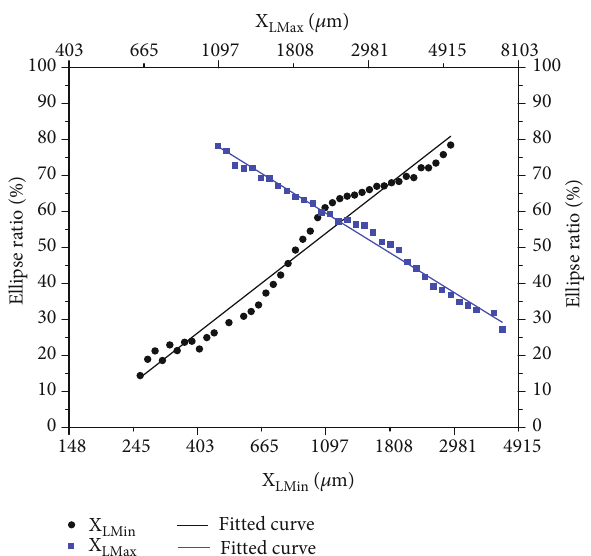
Figure 13: Relationship between the Legendre ellipse diameter X X Lmin ( Lmax ) and ellipse ratio (logarithmic